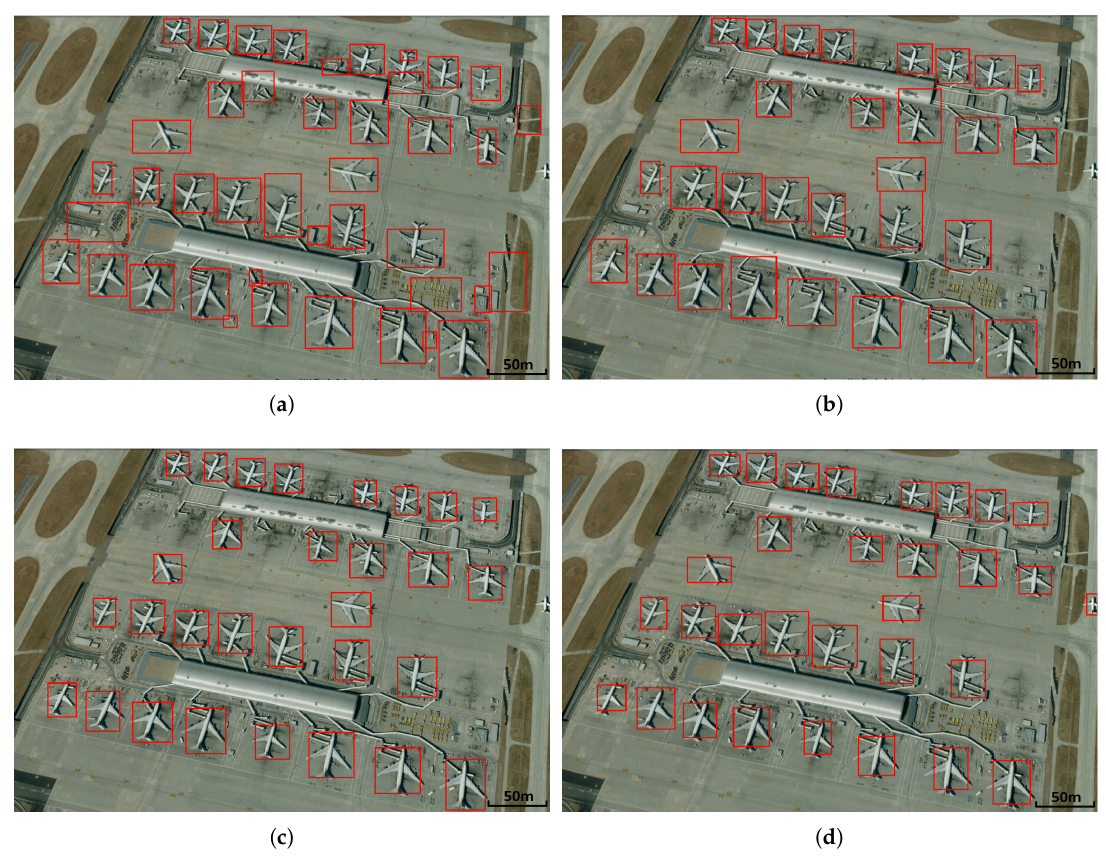
Figure 11. Detection results of different methods in some test samples. The detection results are located with red bounding boxes. ( a ) the detection results of HOG-SVM; ( b ) the detection results of MFCNN [6]; ( c ) the detection results of Faster-RCNN [1]; and ( d ) the detection results of